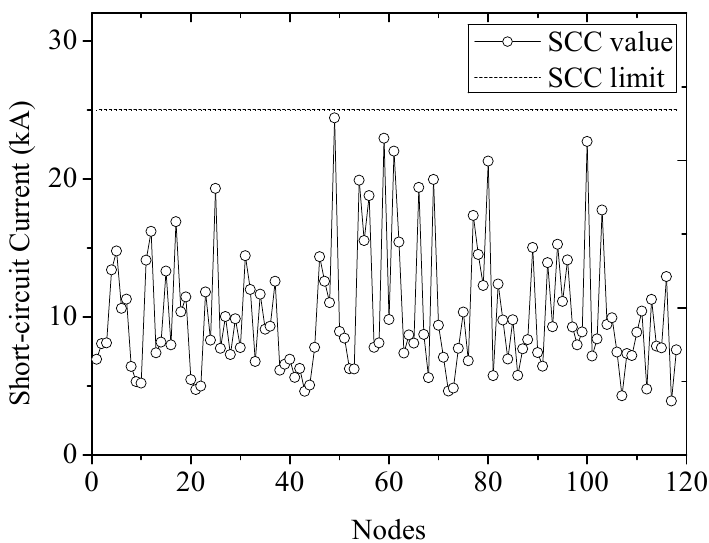
Figure 5. The short-circuit current magnitudes of all the buses in IEEE 118-bus after transmission switching.